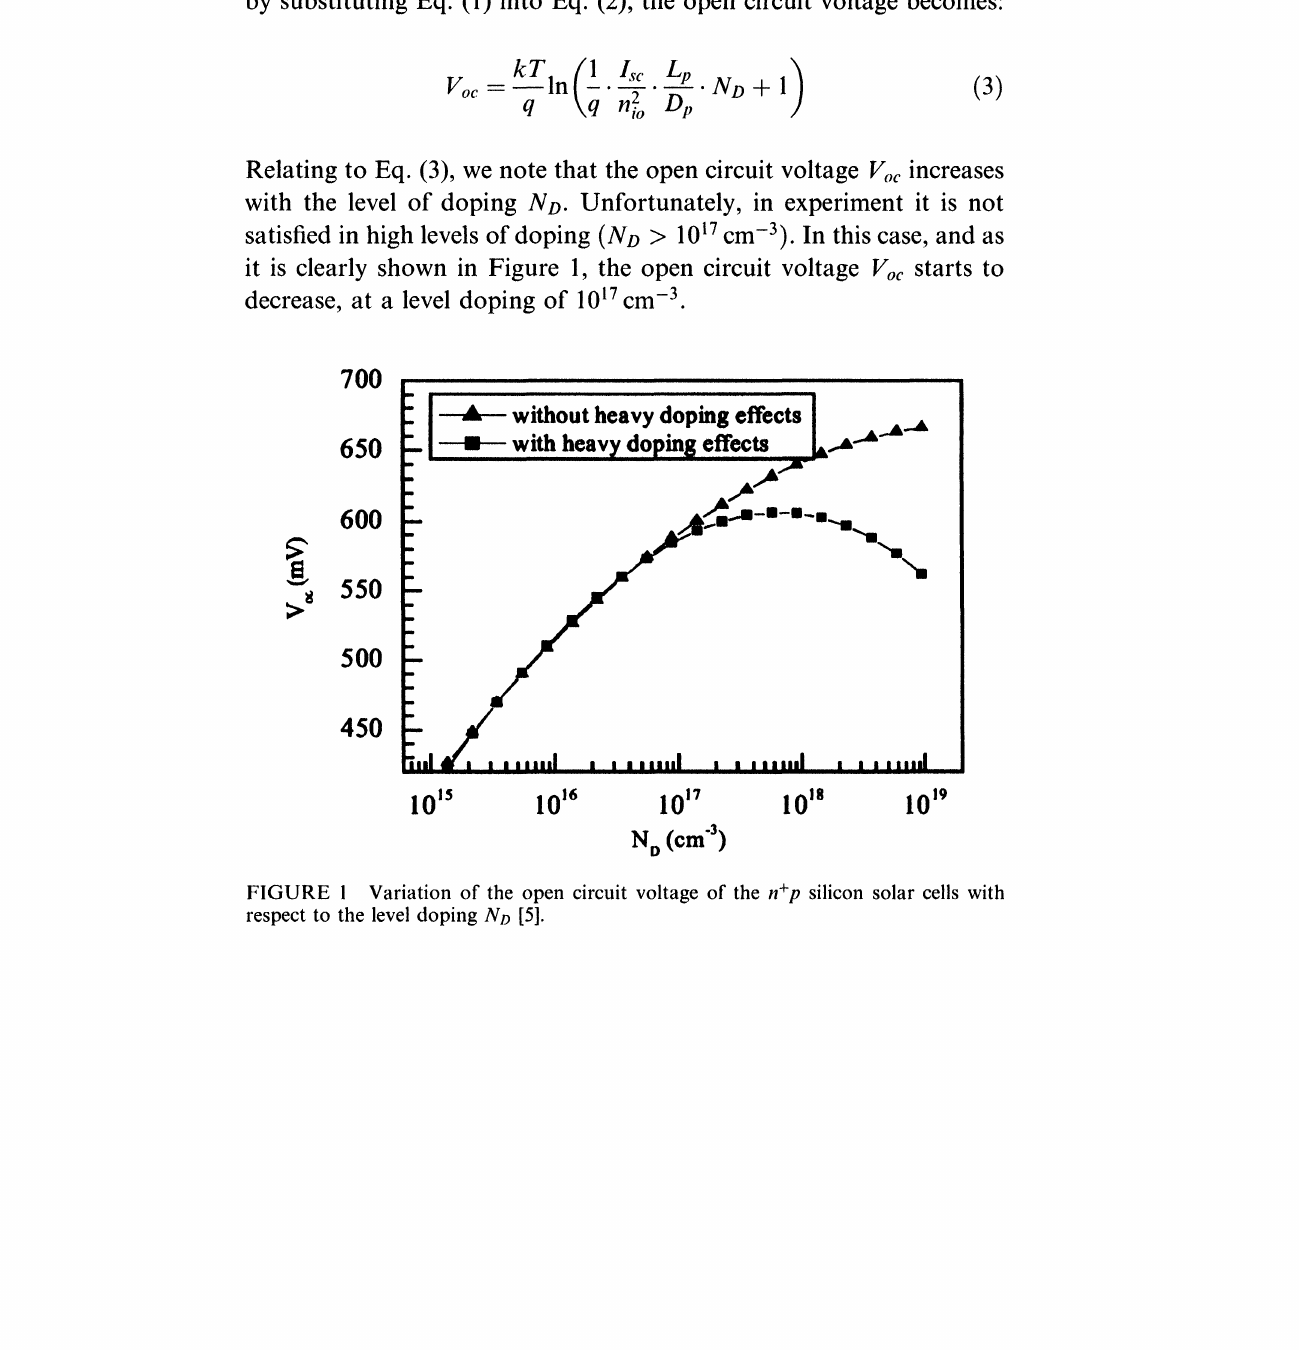
FIGURE Variation of the open circuit voltage of the n+p silicon solar cells with respect to the level doping No